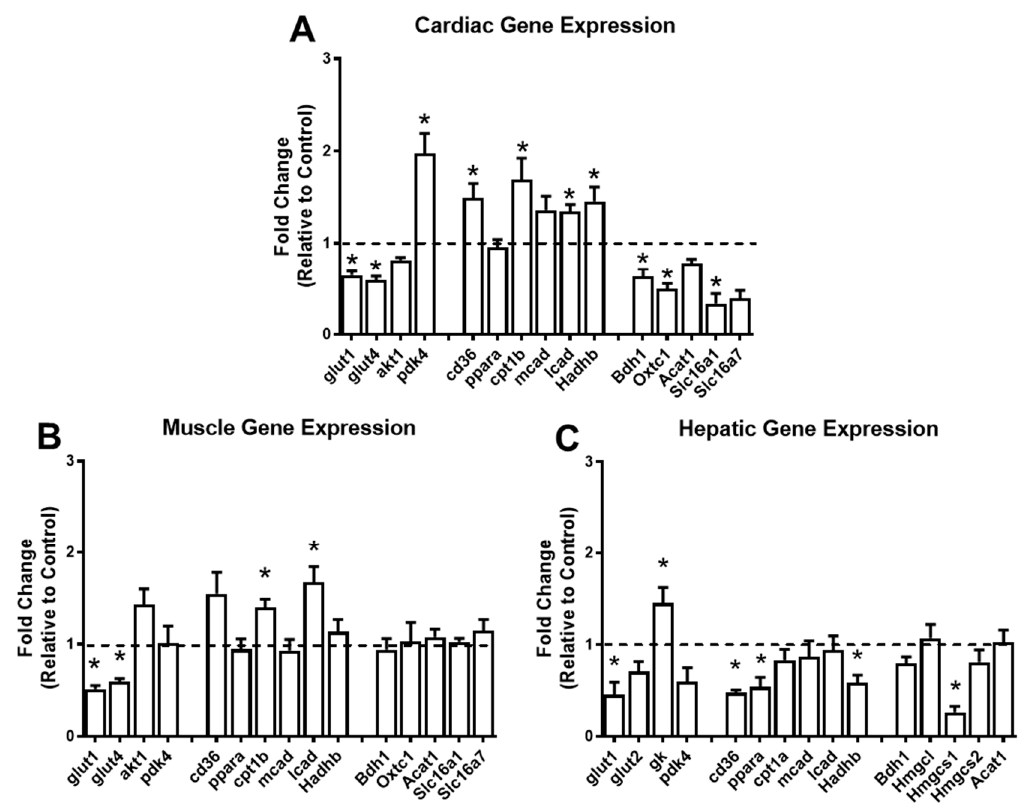
Figure 6. The ketogenic diet alters the expression of cardiac, skeletal muscle, and hepatic genes. Gene expression analysis conducted via RT-PCR in the ( A ) heart ( n = 5 per group); ( B ) gastrocnemius ( n = 4 per group); and ( C ) liver ( n = 4 per group). For each tissue, genes involved in glucose, lipid, and ketone body metabolism were analyzed. Glucose metabolism: glut1 , glucose-transporter 1; glut2 , glucose-transporter 2; glut4 , glucose-transporter 4; akt1 , AKT serine/threonine kinase 1; gk , glucokinase; pdk4 , pyruvate dehydrogenase kinase 4. Fatty acid metabolism: cd36 , cluster of differentiation 36; ppara , peroxisome proliferator-activated receptor alpha; cpt1b , carnitine palmitoyltransferase 1B; cpt1a , carnitine palmitoyltransferase 1A; mcad , medium chain acyl-CoA dehydrogenase; lcad , long-chain acyl-CoA dehydrogenase; hadhb , hydroxyacyl-CoA dehydrogenase trifunctional multienzyme complex subunit beta. Ketone body metabolism: bdh1 , 3-hydroxybutyrate dehydrogenase 1; Oxct1 , 3-oxoacid CoA-transferase 1; Acat1 , acetyl-CoA acetyltransferase 1; Slc16a1 , monocarboxylate transporter 1; Slc16a7 , monocarboxylate transporter 2; Hmgcl , 3-hydroxy-3-methylglutaryl-CoA lyase; Hmgcs1 , hydroxymethylglutaryl-CoA synthase 1; and Hmgcs2 , hydroxymethylglutaryl-CoA synthase. * p < 0.05 vs. chow.